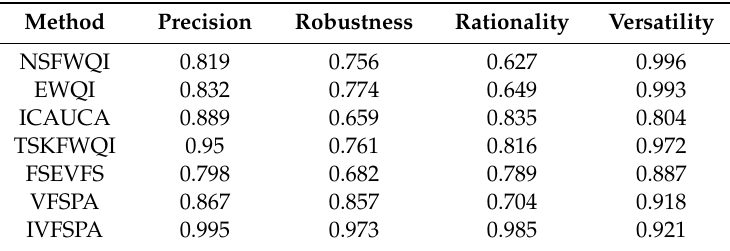
Table 6. Experimental results of metrics validation.